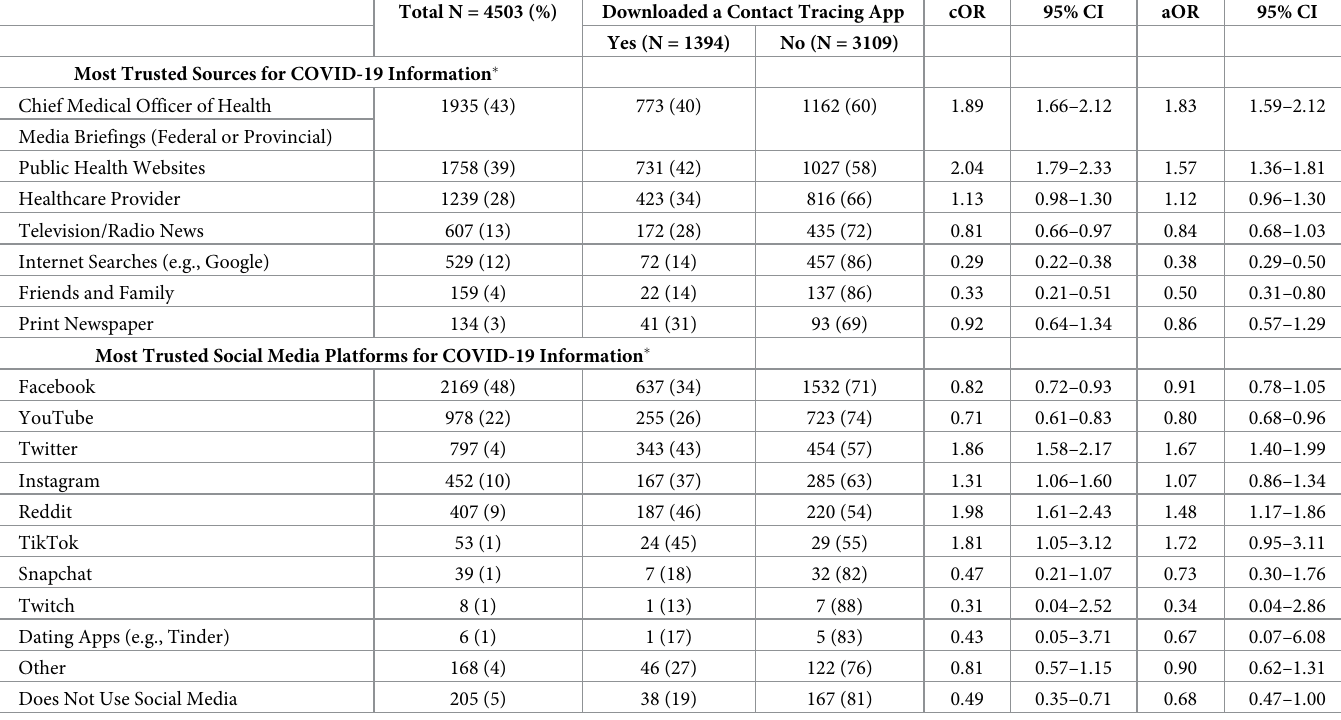
Table 3. Associations between COVID-19 contact tracing applications downloads and trusted sources of COVID-19